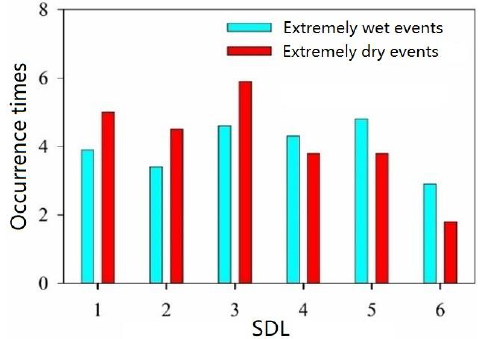
SDLs between 2000 – 2018 in mainland China. SDLs between 2000–2018 in mainland